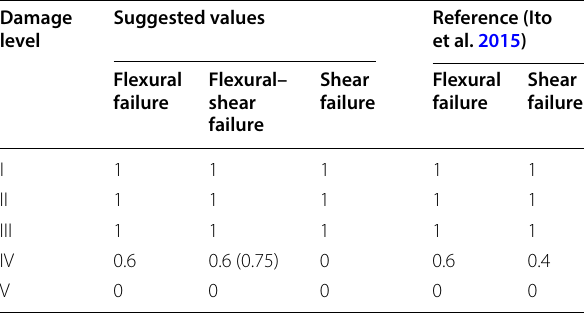
The value in the parentheses represent experimental reduction